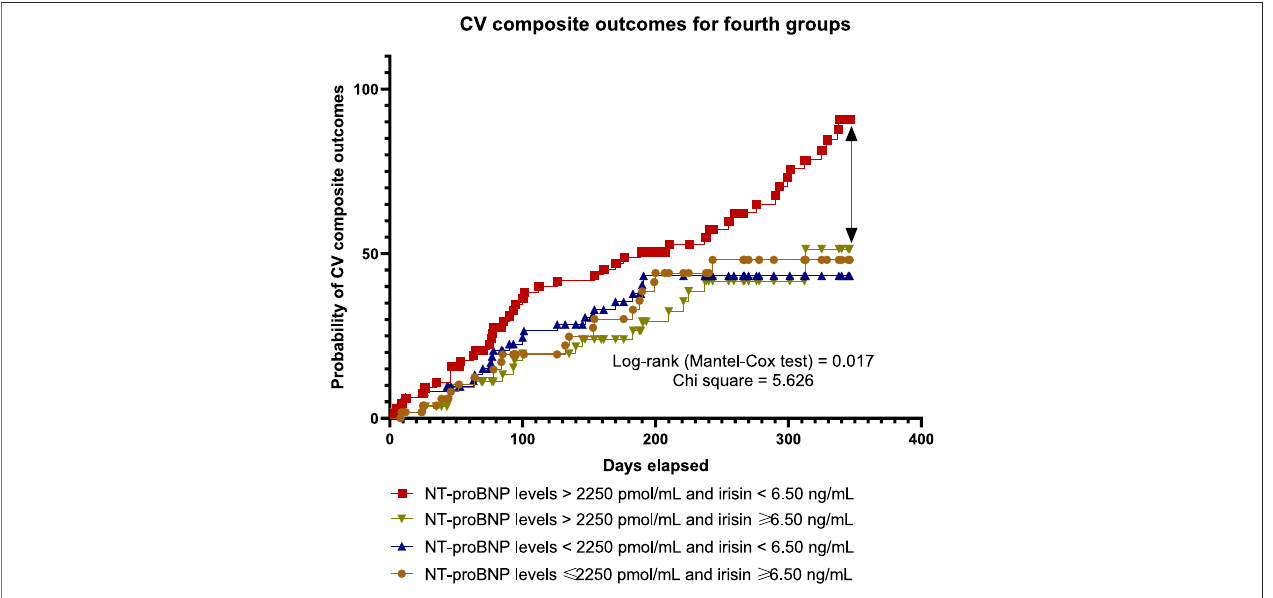
FIGURE4| Kaplan-Meiercurvesillustrateadifferencebetweensubgroupsinaccumulationofpre-speci fi edclinicaloutcomesdependingonthelevelsofcirculating biological markers.